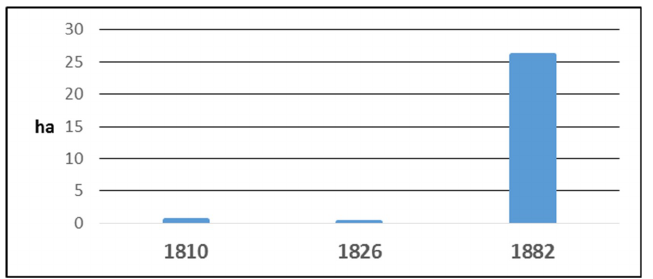
Figure 5. Evolution of the occupations of Castel di Sangro‑Lucera. Years 1810, 1826, 1882. Source: National Archives of Foggia Source: National Archives of Foggia, Atlases 2, 39,